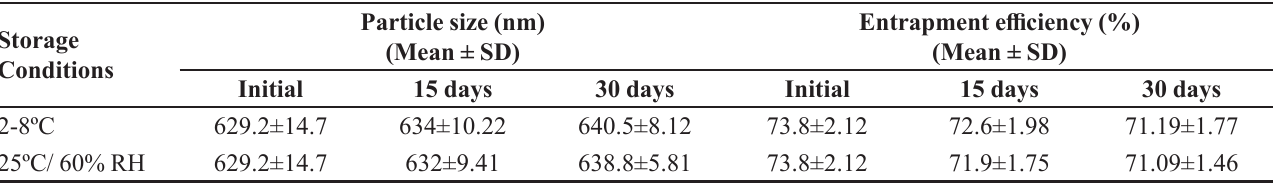
The values are expressed as Mean ±